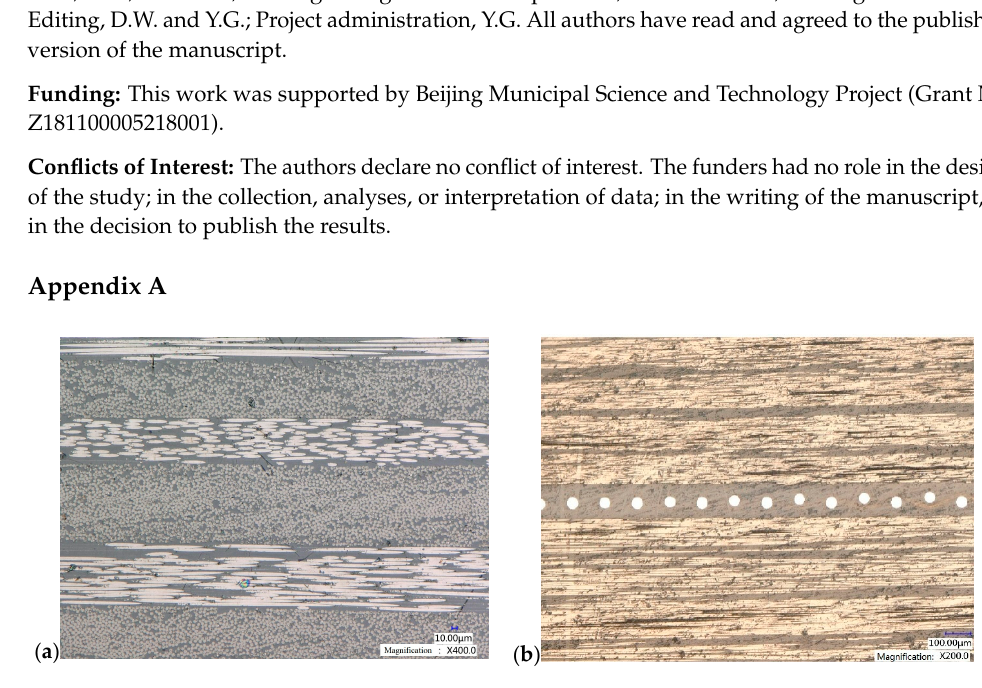
Figure A1. Cross-section image of ( a ) the laminate and ( b ) the welded composite.